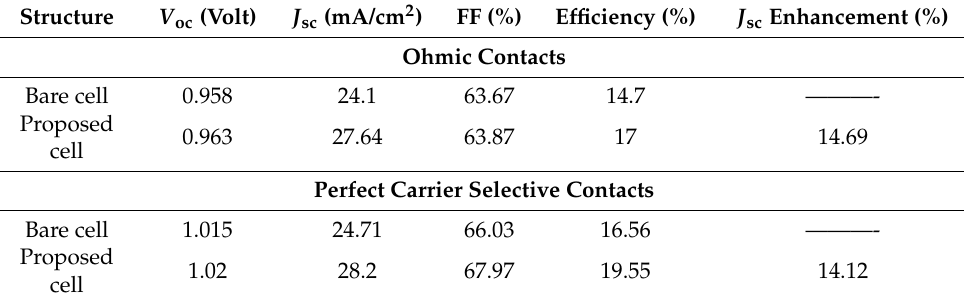
Figure 14. Applied voltage vs. current density for the bare InP NW array solar cell and for proposed cell, applied voltage vs. photovoltaic efficiency for the bare InP NW array solar cell and for proposed cell for ( a – b ) ohmic contacts ( c – d ) perfect carrier selective contacts. Table 2. Electrical result for the bare and proposed InP NW array solar